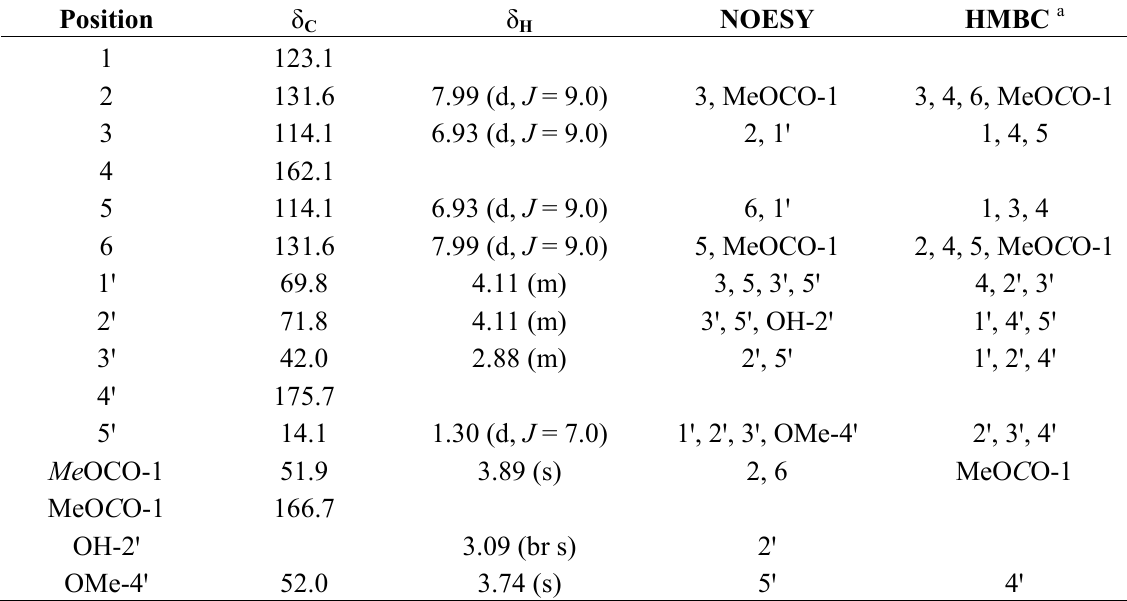
Table 1. 1 H- and 13 C-NMR data of 2 . At 500 ( 1 H) and 125 MHz ( 13 C) in CDCl J in